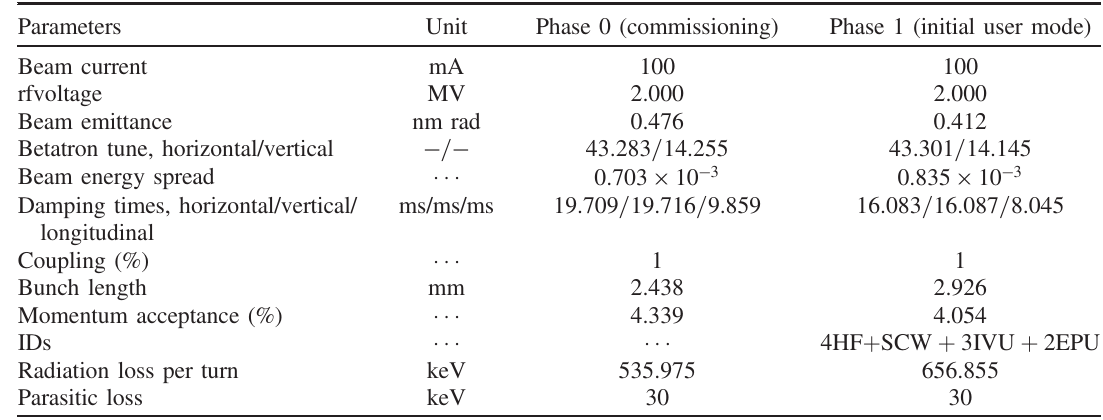
TABLE V. The operation scenarios for the ILSF storage ring. Beta beating is corrected by the nearest quadrupoles to the IDs. Maximum change in the gradient of the quadrupoles is 0 . 23 T = m.